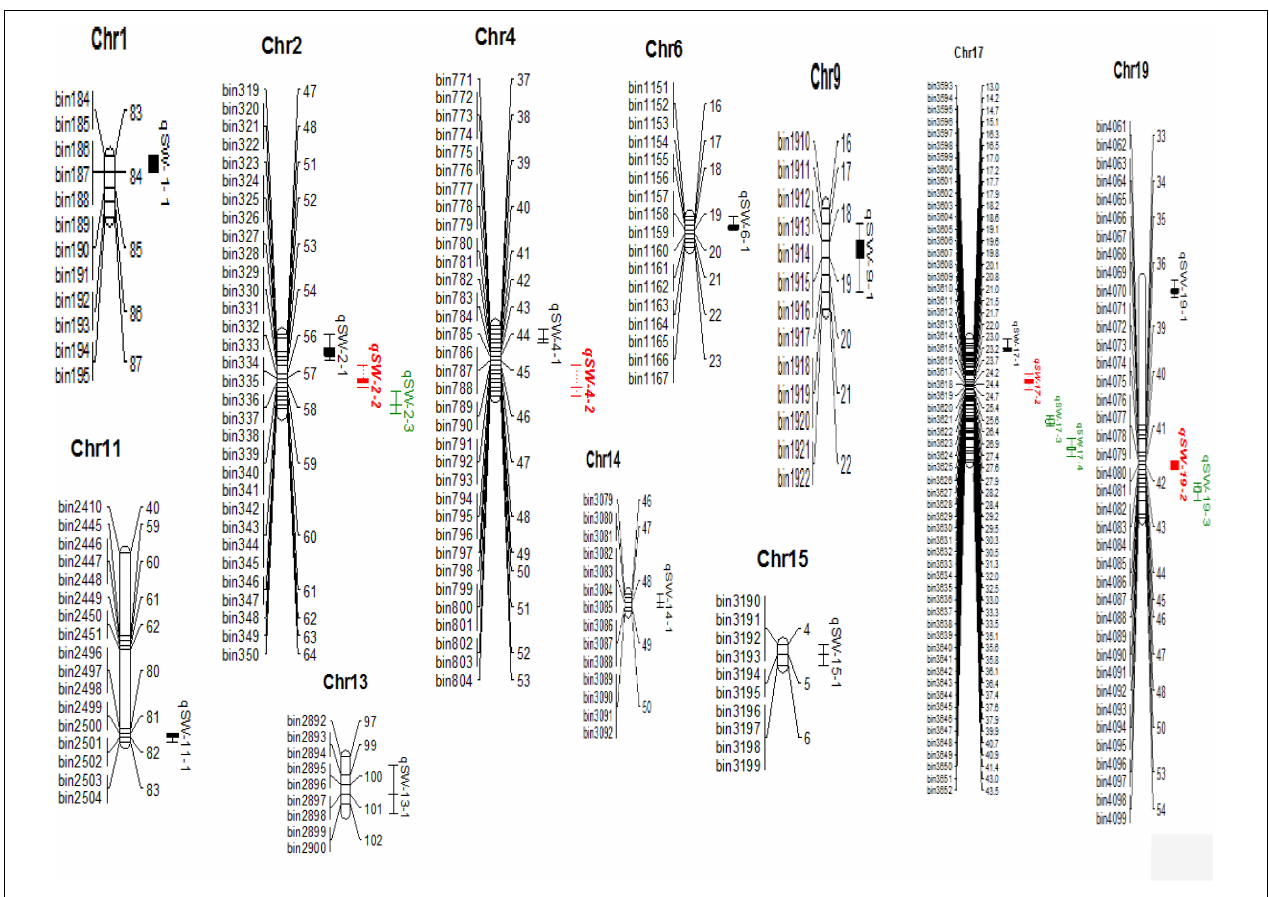
FIGURE 2 | 100-seed weight QTLs identified in NJIR4P-RIL (complete map is not presented here, it represents only the portion where QTLs have been identified). Right side of chromosomes indicates the interval distance between markers using cM (centiMogan) as the unit; the left side of chromosomes indicates Bin-DNA